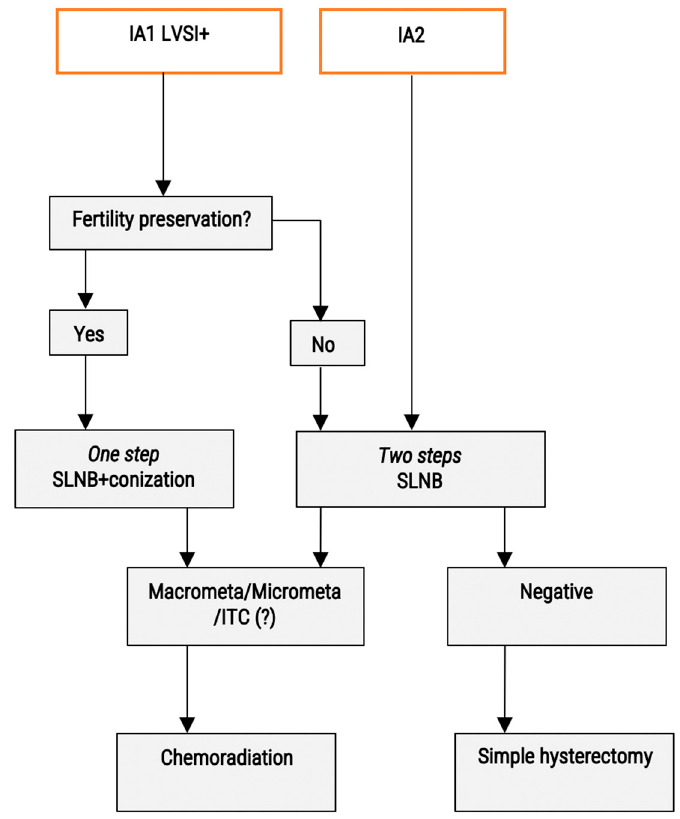
Figure 1. Proposed algorithm for the nodal management of early stage cervical cancer—Stages IA. LVSI: lympho-vascular space invasion; ITC: isolated tumour cells; SLND: sentinel lymph node bi- opsy .